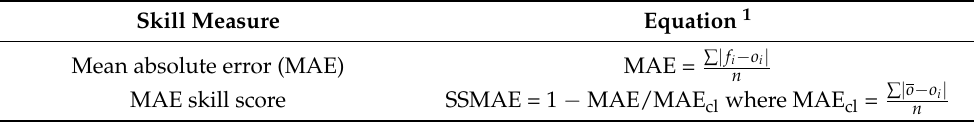
Table 3. The summary of measurements of forecast skill.